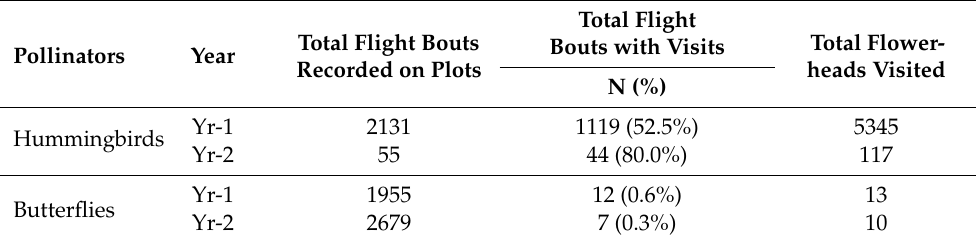
Table 1. Total visits by hummingbirds and butterflies recorded on M. subulata flower-heads over